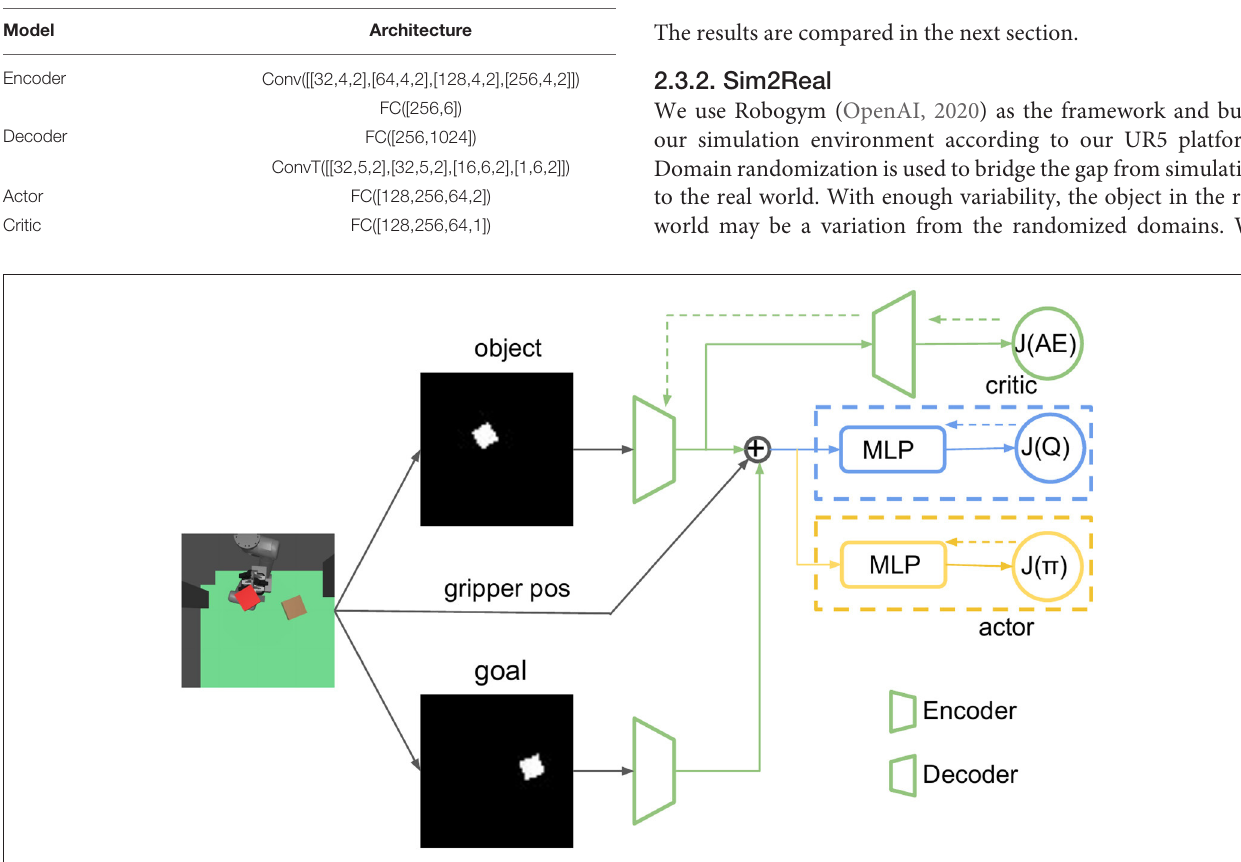
FIGURE 6 | The network structure of our reinforcement learning (RL) framework, in which dashed arrows represent back propagation. VAE and RL are trained separately, encoders from VAE do not update during the RL training process. The critic and actor parts are optimized by value target J ( Q ) and expected future return J ( π